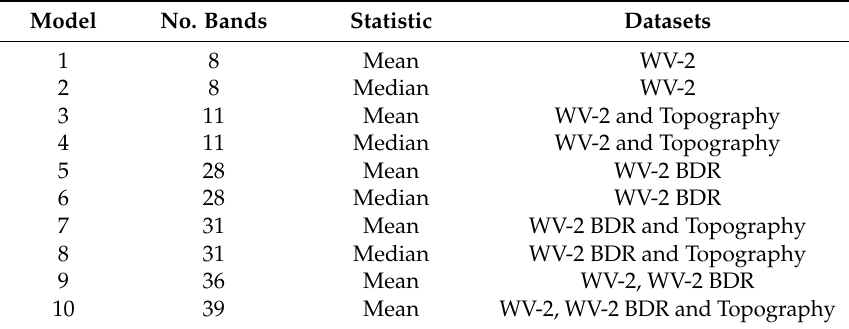
Table 3. Models generated, number of bands, band statistics and datasets.